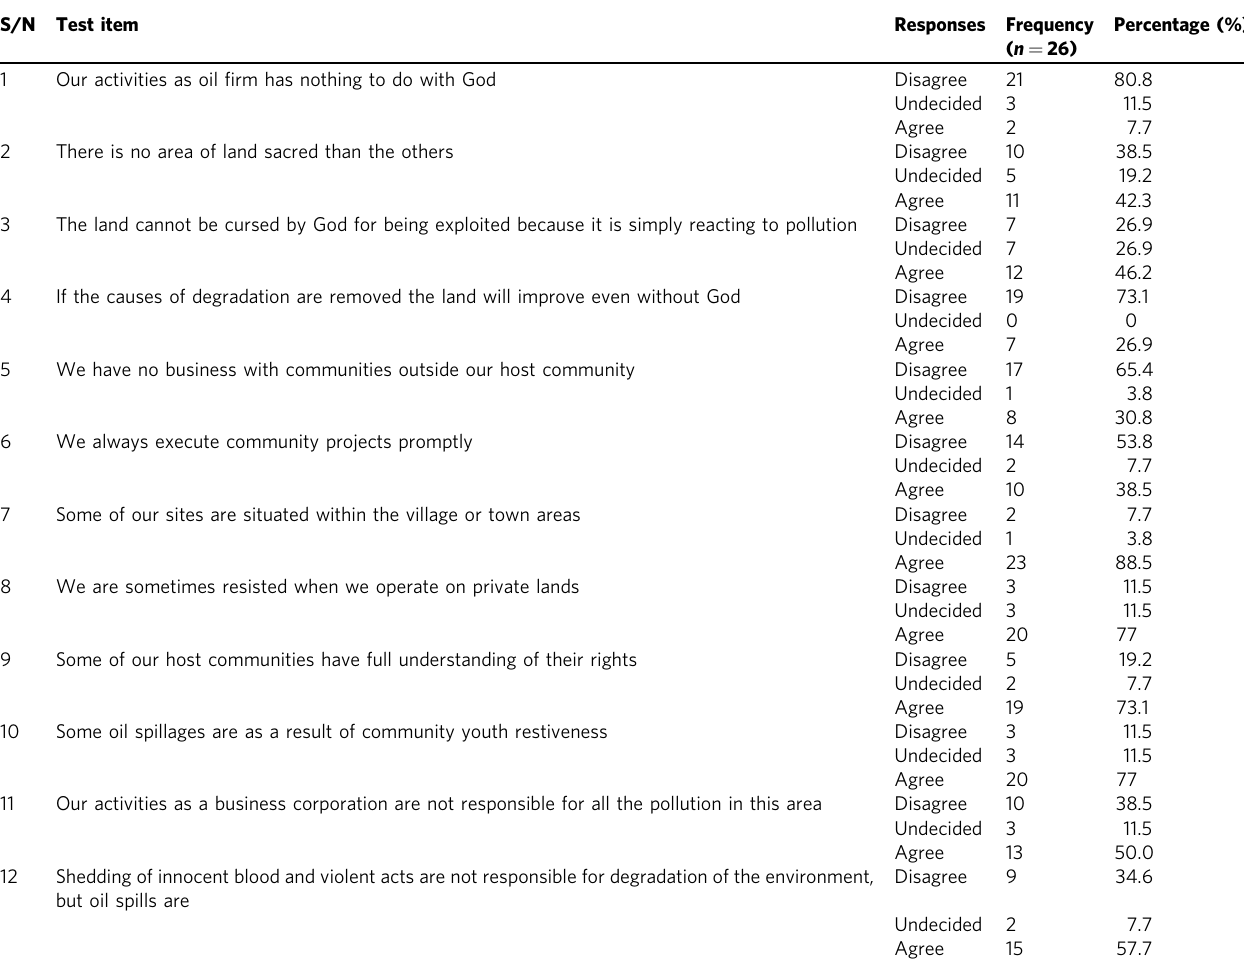
Table 2 The MNC's adherence to policy otherwise presented as the 'knowledge of God'. S/N Test